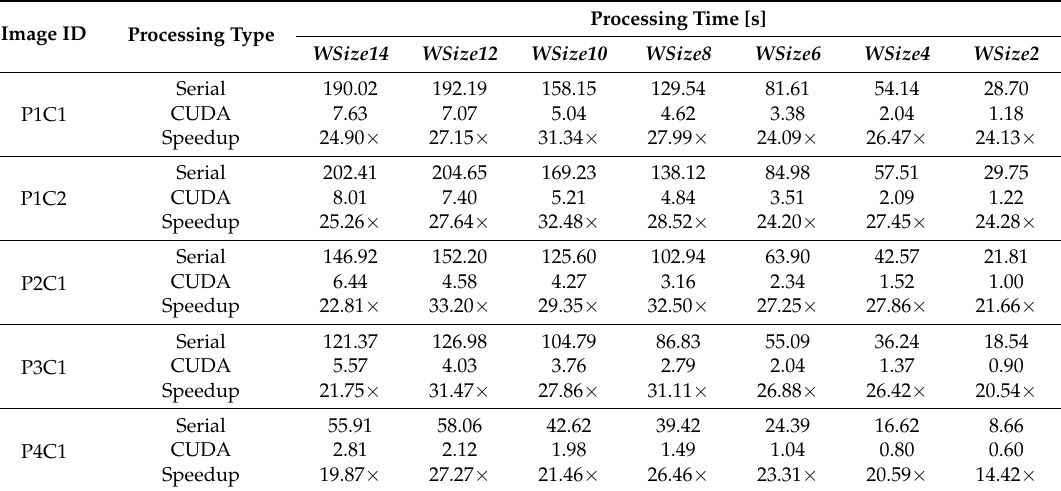
Table 6. Execution time results of the serial and parallel implementations using the Manhattan distance and using different window sizes.